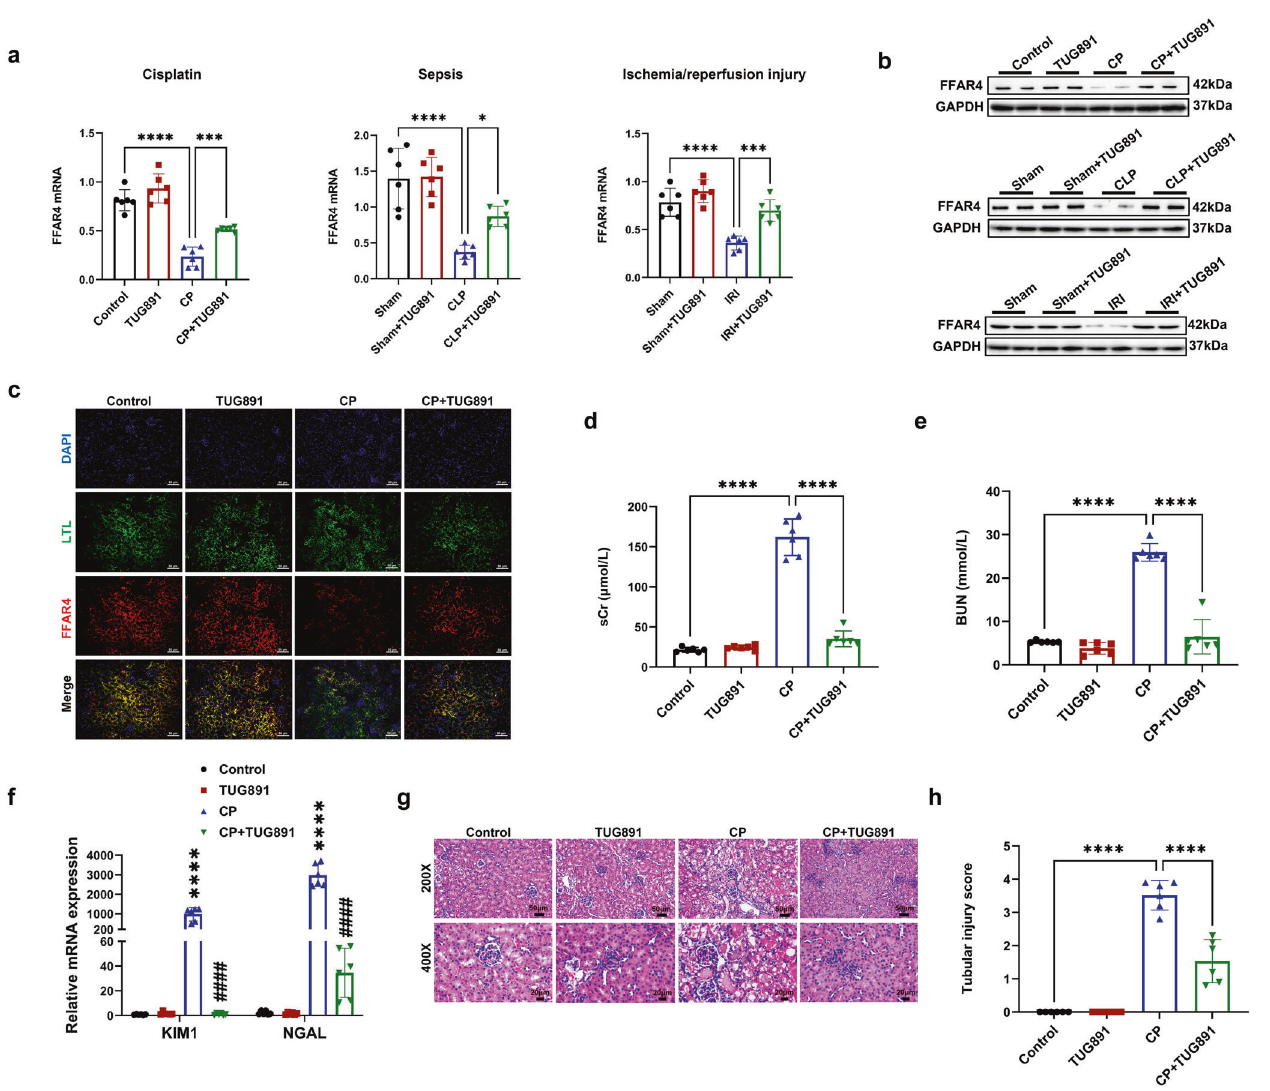
CP + TUG891 vs. CP). g Representative images of hematoxylin and eosin (H&E) staining (200×, scale bar = 50 μ m; 400×, scale bar = 20 μ m). h Tubular injury scores of kidney tissues ( n = 6). Data are presented as mean ± SD. CP cisplatin. CLP cecal ligation/perforation. IRI,